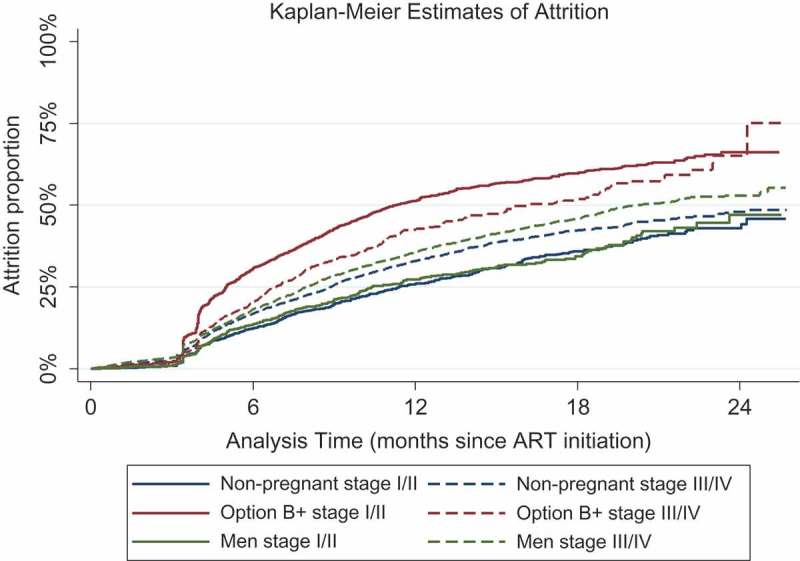
ART attrition by time since ART initiation by patient group and HIV disease stage.